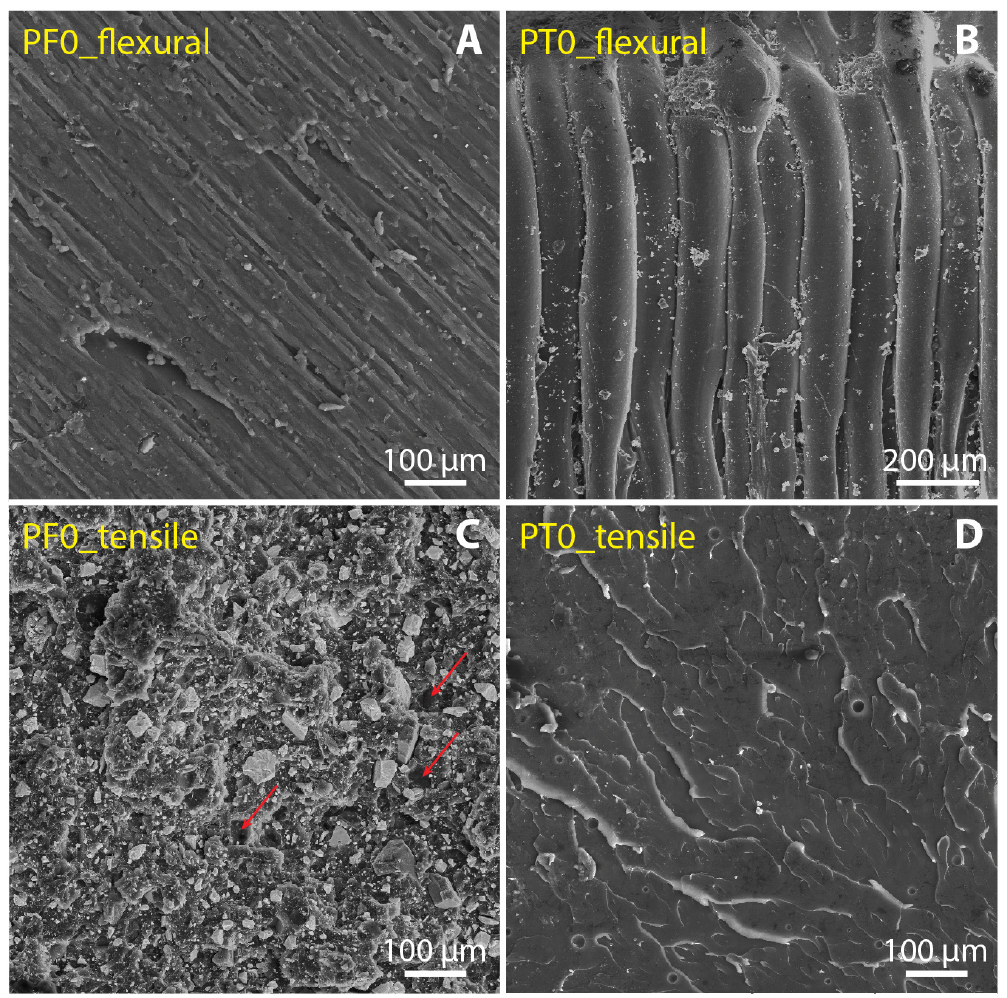
Figure 7. SE images of PF0 and PT0 showing the fracture surfaces after the flexural ( A , B ) and tensile tests ( C , D ).